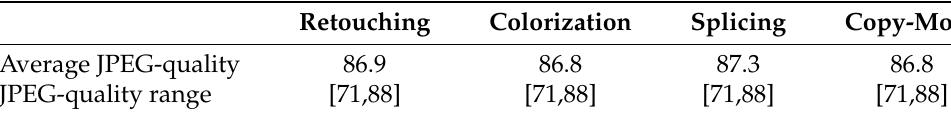
Table 1. Average JPEG-quality and range for each of the datasets.